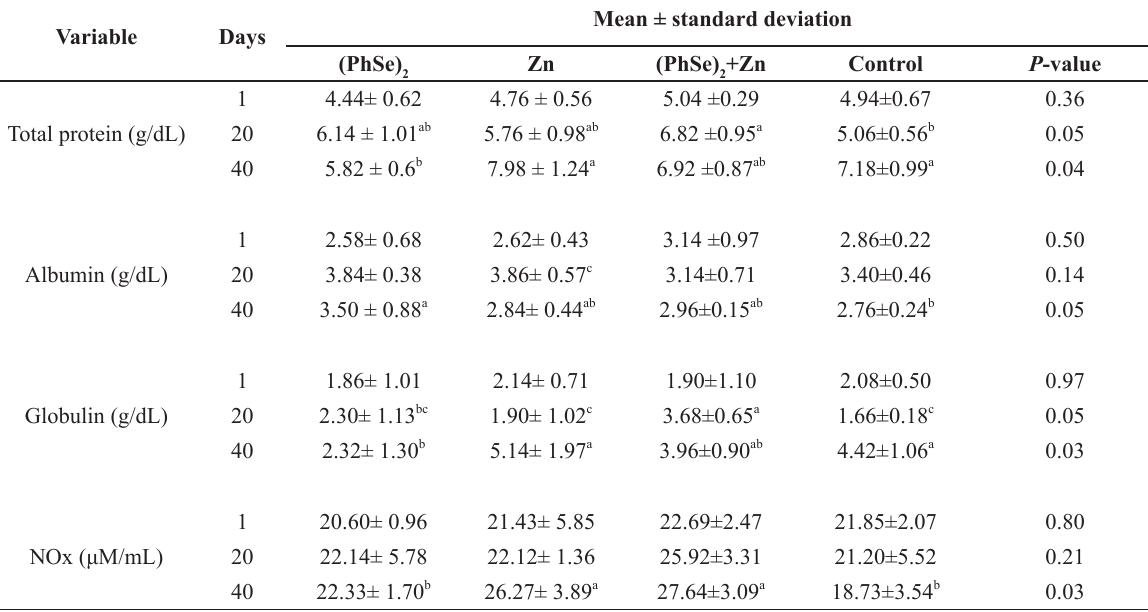
Mean and standard deviation of blood components for each group at the day 1, 20 and 40 of the experiment. Different letters mean significant difference between